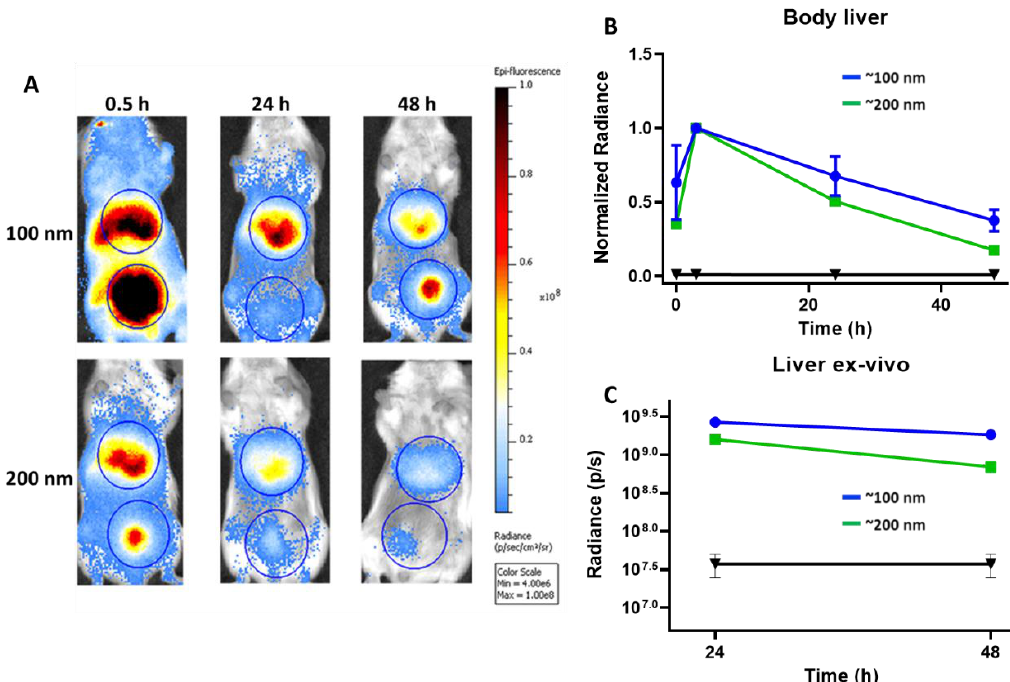
Figure 4. ( A ) Fluorescent whole-body images of mice obtained at different time points up to 48 h after intravenous (i.v.) administration of ~200 nm and ~100 nm PLGA particles. The liver and bladder are encircled. ( B ) Variations of liver fluorescence in whole-body images. The fluorescence intensities are normalized at maximum values observed at 3 h after administration of ~100 nm (blue) and ~200 nm (green) PLGA particles. ( C ) Variations of liver fluorescence intensities of ~100 nm (blue) and ~200 nm (green) PLGA particles obtained on an isolated liver at 24 h and 48 h after particle administration. Data obtained for untreated mice (negative control) are shown in black.